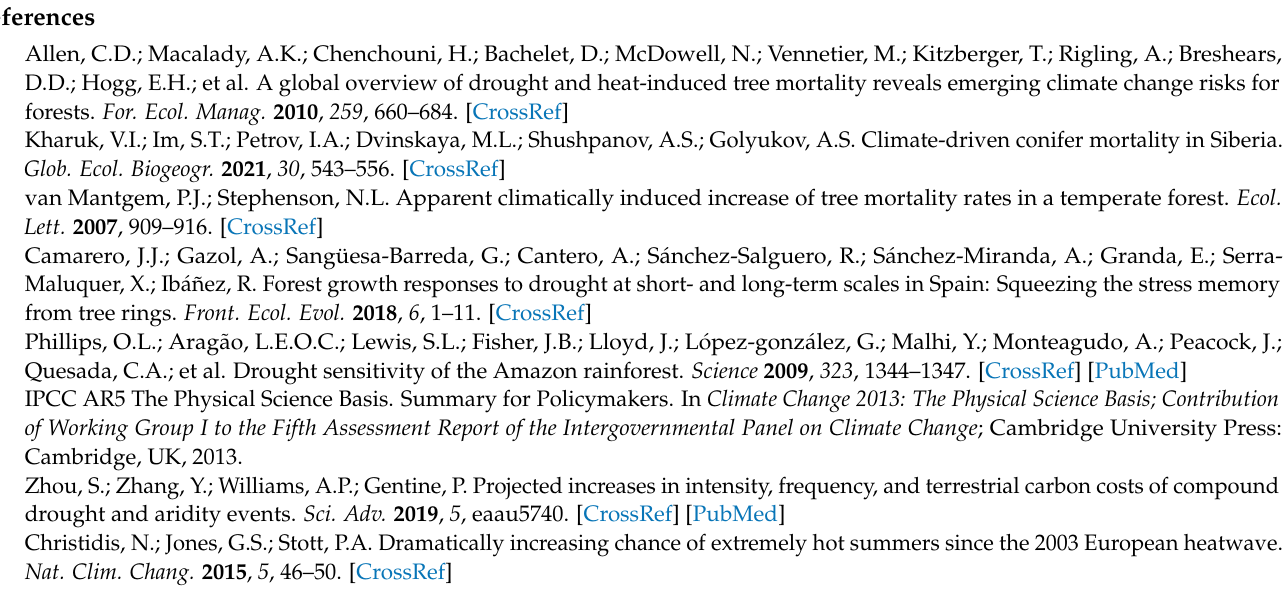
Figure A1. Mean temperature ( a ), total precipitation ( b ) and Standardized Precipitation Evaporation Index (SPEI) ( c ) of the growing season (previous October–March) calculated with data obtained from Bariloche airport weather station. In ( a ) and ( b ) straight thick lines represent significant temporal trends. In ( c ) black dots indicate severe drought events under the − 1.5